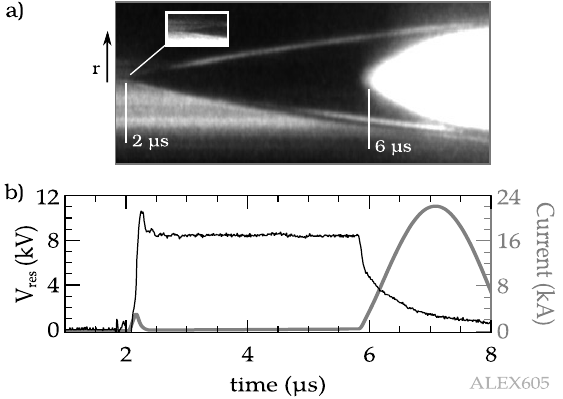
Figure 2. ( a ) Exploding wire shadow streak image; ( b ) Voltage( ) and current( ) signals for a